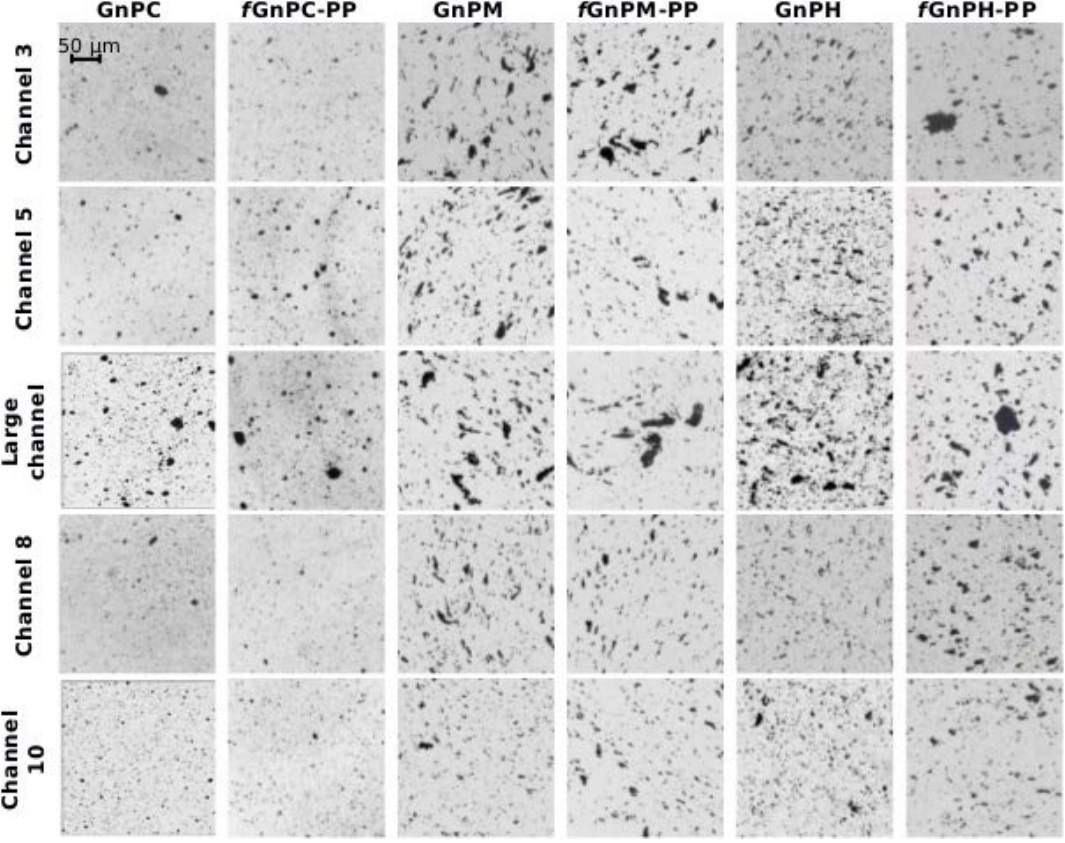
Figure 3. Optical micrographs of samples of PP nanocomposites containing GnP and f GnP-PP collected from a prototype small-scale extensional mixer.